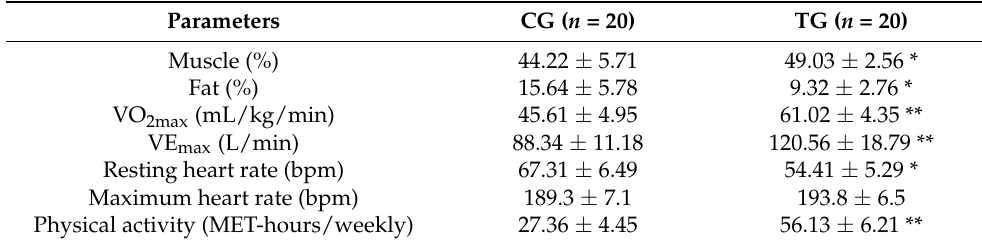
Table 1. Characteristics of participants.